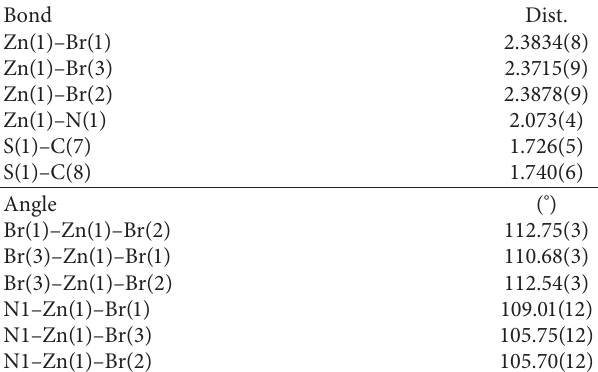
Table 6: Selected bond lengths (˚A) and bond angles ( ° ) of complex 2. Bond